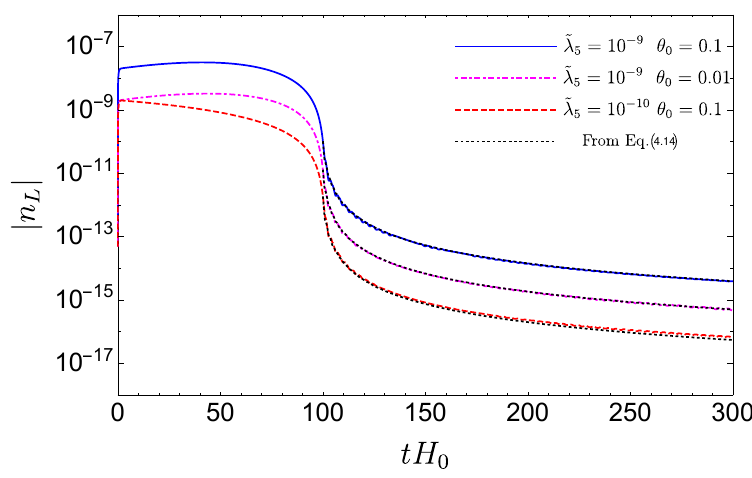
Figure 3 . Comparison of the lepton number density n L derived from the full numerical calcu- lations (Coloured lines) and the analytical estimation (Black dotted lines) in eq. (4.14), through the inflationary and oscillatory epochs. The results are presented for varying θ parameters are in Planck units and we define H and λ = 4 . 5 · 10 − 5 . We take ˜ µ to be sufficiently small to not affect the dynamics, and the following initial conditions are chosen, χ